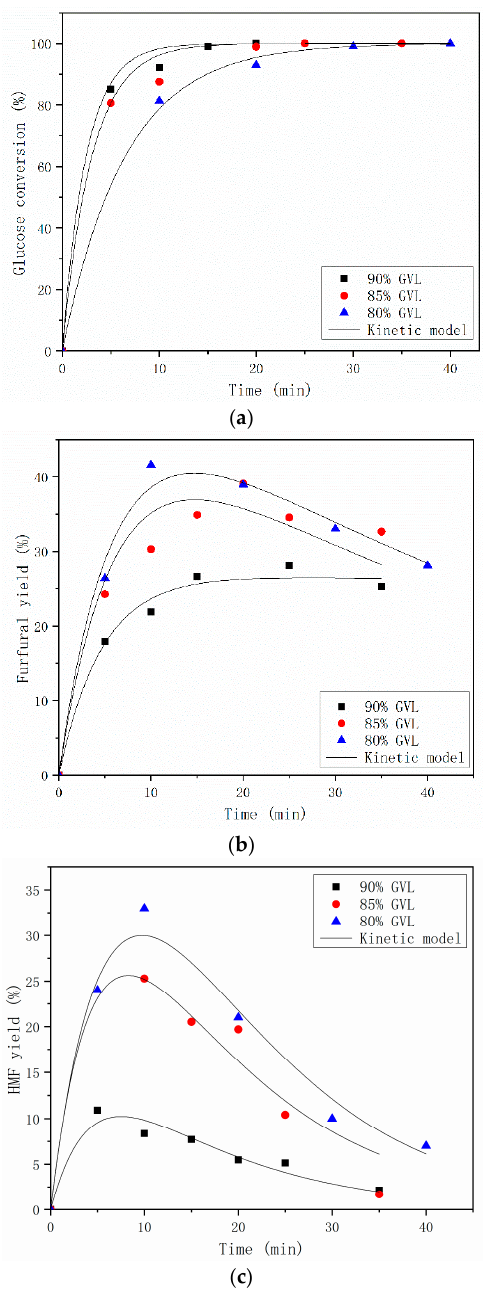
Figure 2. Comparison of experimental data and kinetic models for ( a ) glucose conversion, ( b ) furfural production, and ( c ) HMF production as a function of different ratios of GVL to water. Reaction conditions: temperature: 443 K; 0.0555 mol L − 1 glucose; 0.1 wt% H 2 SO 4 ; and 0.014 mol/L SnSO 4